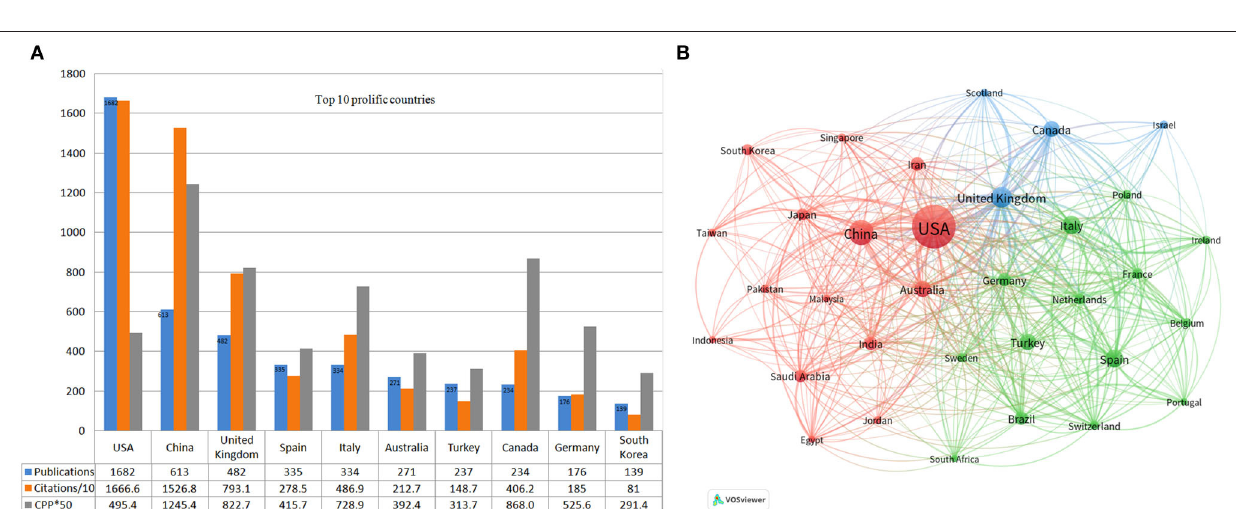
FIGURE 5 | (A) Top 10 prolific countries, the number of publications, total citations ( × 0.1), and citations per publication ( × 50) for each country. (B) Collaboration among countries. Node size indicates the number of articles. The width of links indicates the cooperation